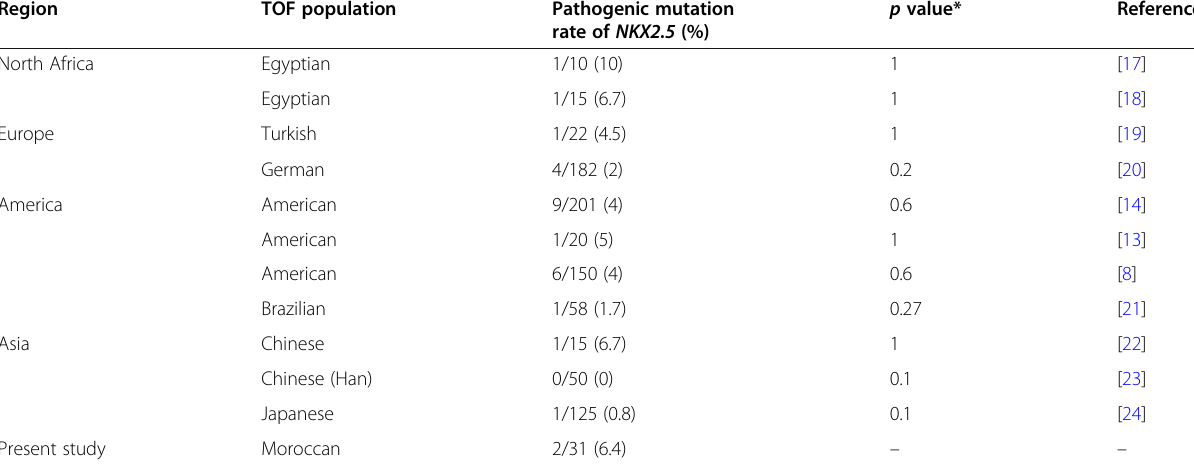
Table 3 Comparison of NKX2.5 mutation rate throughout various tetralogy of Fallot (TOF) populations Region